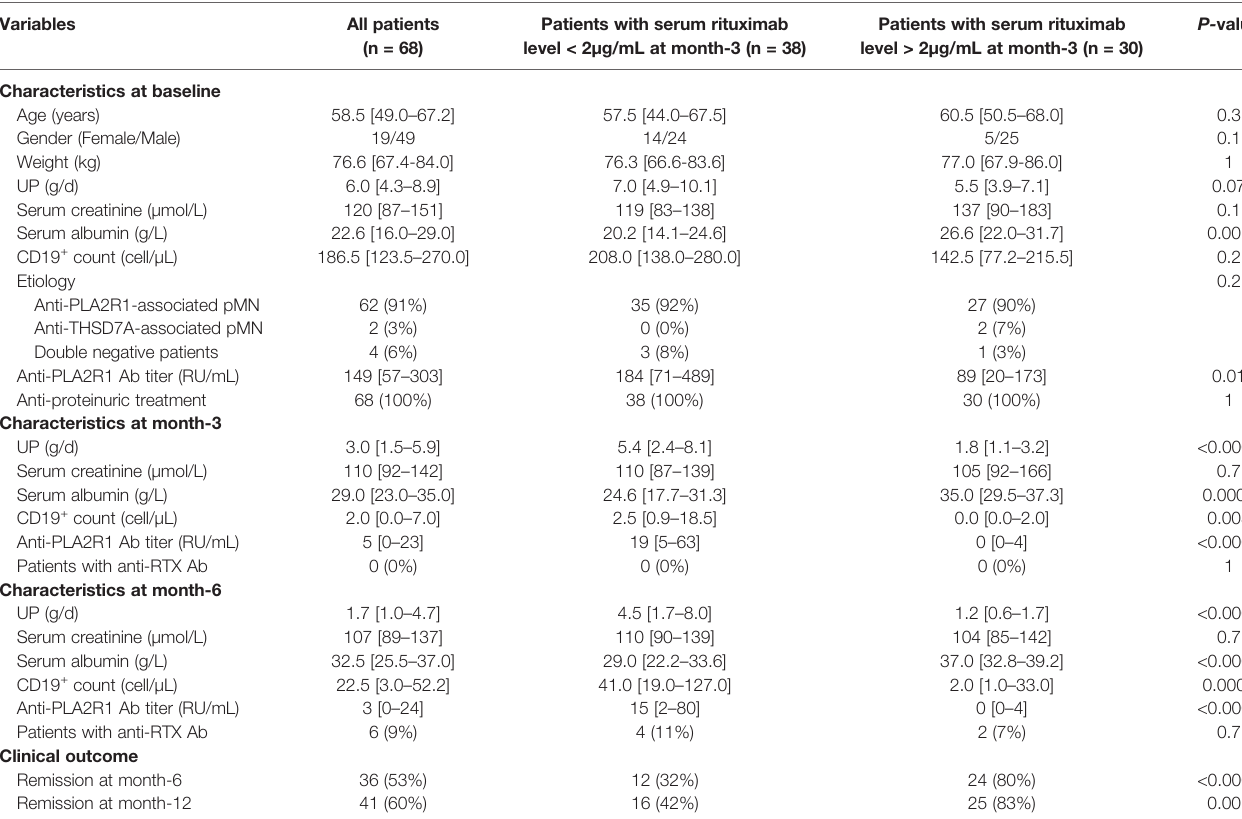
TABLE 1 | Characterization of patients at baseline (i.e. the day of rituximab injection) and during follow-up.